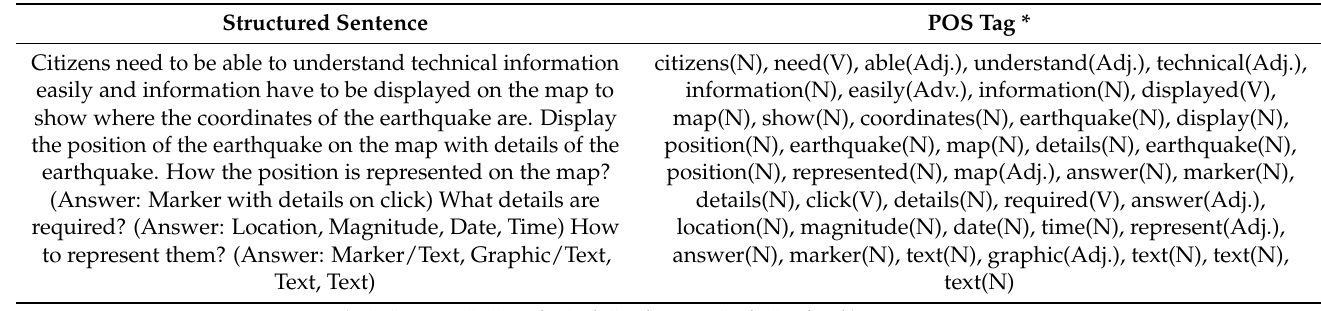
Table 4. The outcome of POS tagging on structured requirement